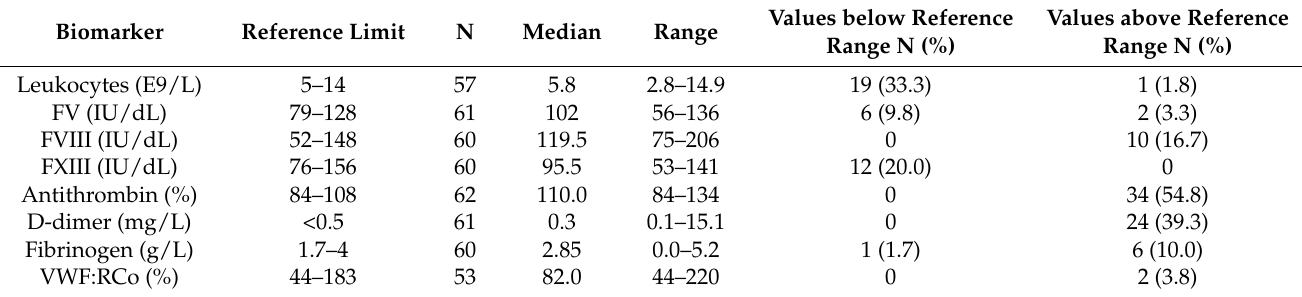
Table 2. Abnormalities in blood cell count, coagulation factors, and natural